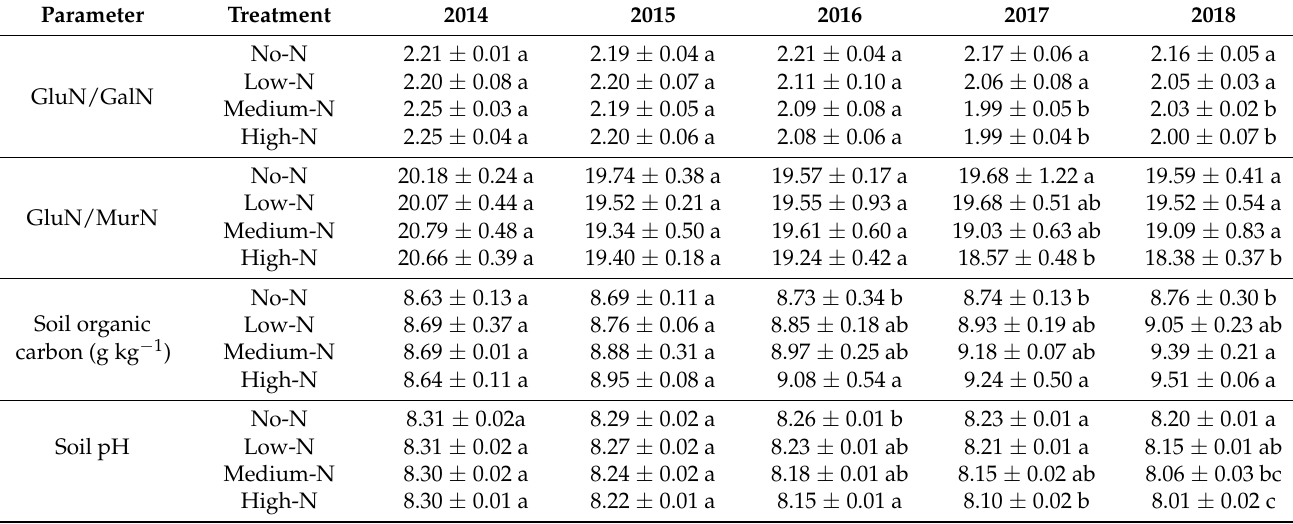
Mean values marked by different letters within the same column and parameter are significantly different from each other at 0.05 probability